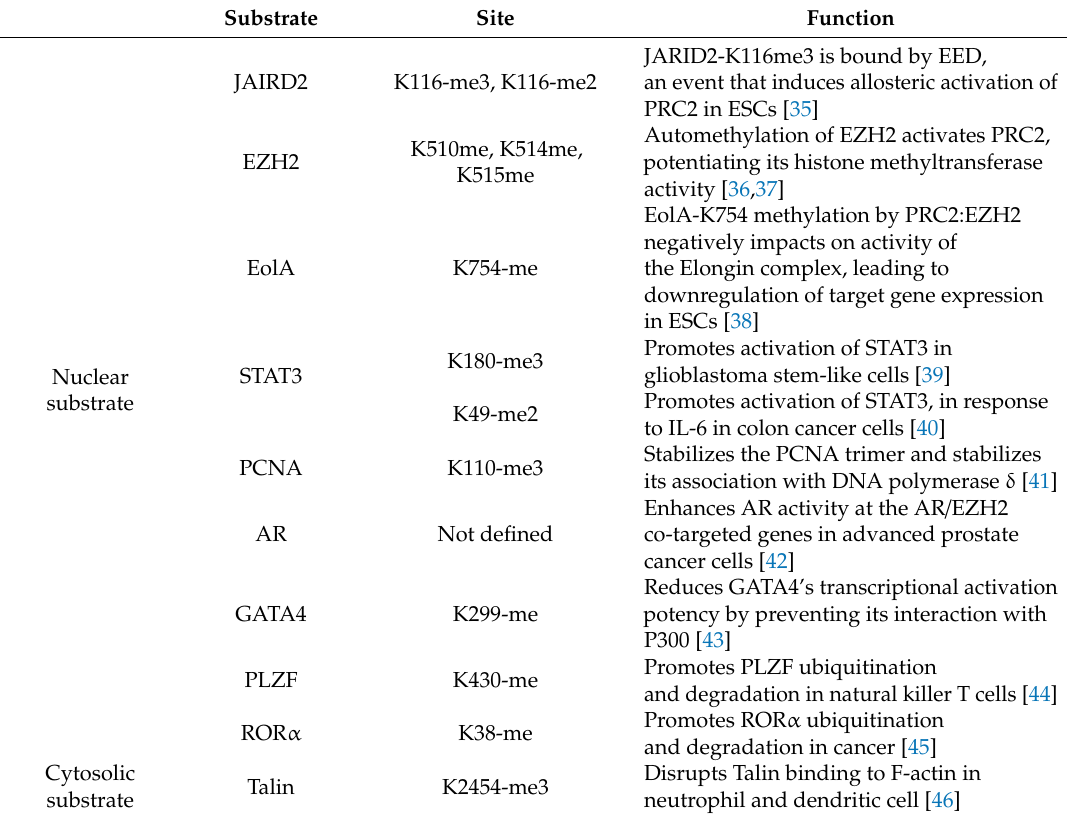
Table 1. Summary of nonhistone substrates of EZH2, methylation site, and related biological